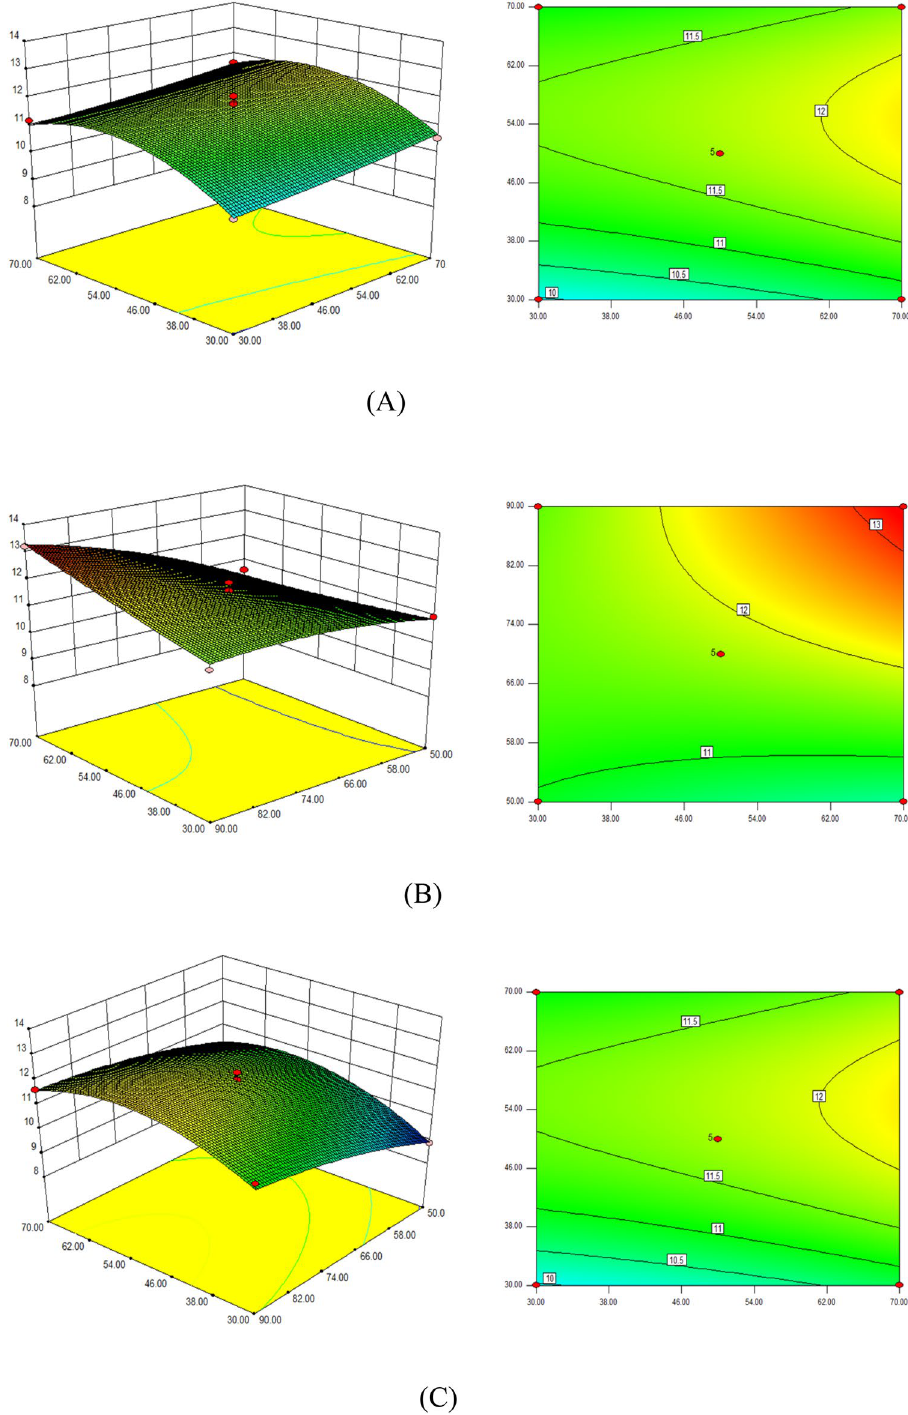
Figure 3. Extraction response surfaces with changes of variable factors: ( A ) Extraction result depending on time and liquid to material ratio, with fixed temperature (80 °C). ( B ) Extraction result depending on time and temperature, with fixed liquid to material ratio (52.56:1 (mL/g)). ( C ) Extraction result depending on liquid to material ratio and temperaturem, with fixed time (70